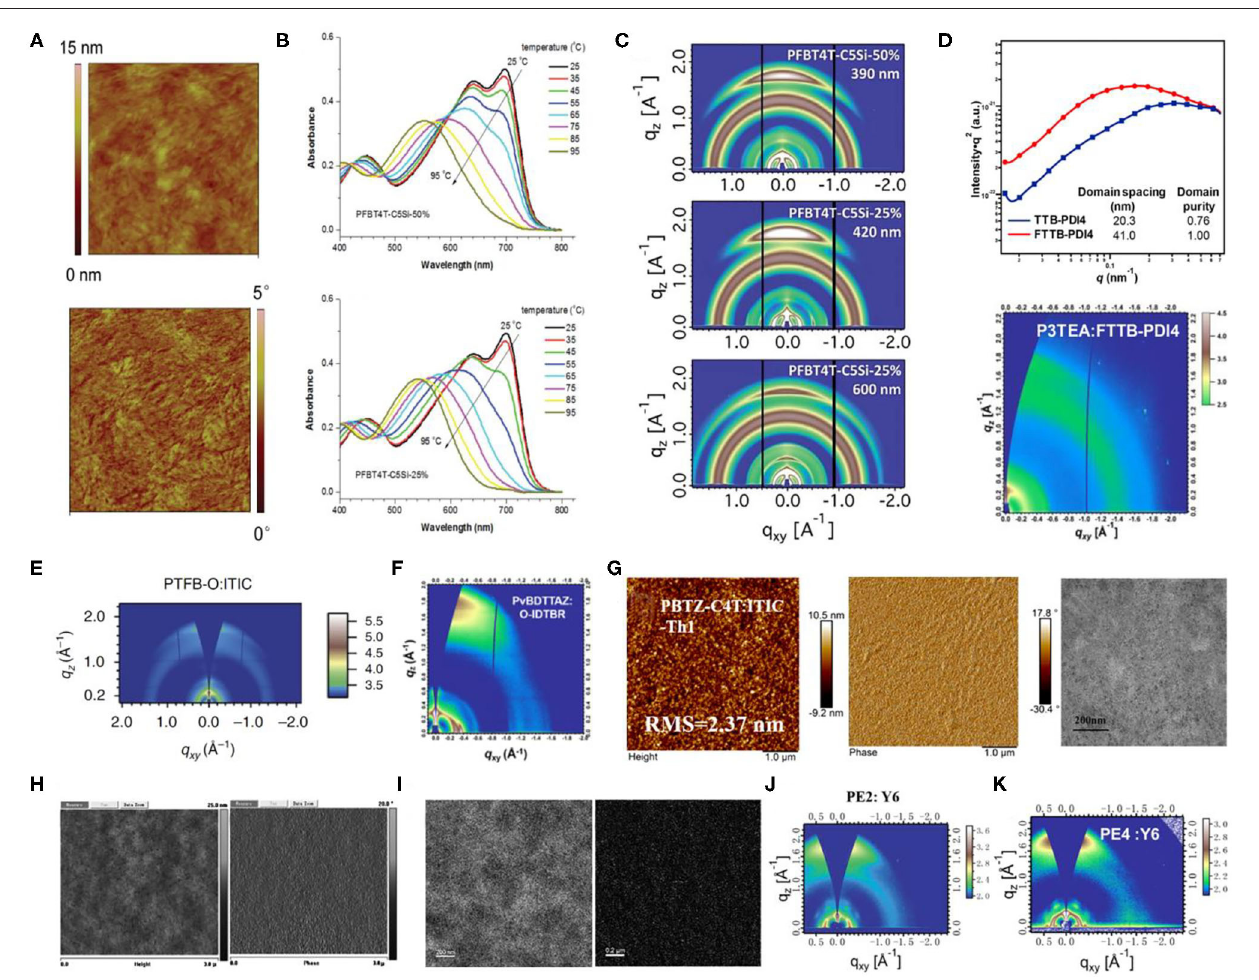
FIGURE 11 | (A) AFM images (1 × 1mm) of PffBT4T-2DT:SF-PDI2 blends. Copyright 2015, The Royal Society of Chemistry. (B) The evolutions of UV-vis absorption spectra of PFBT4T-C5Si-50% (top) and PFBT4TC5Si-25% (bottom) in chlorobenzene (1 × 10 − 5 M) during the heating process from 25 to 95 ◦ C. Copyright 2017, The Royal Society of Chemistry. (C) Grazing incidence X-ray diffraction (GIXD) 2D scattering images of thick BHJ films of PFBT4T-C5Si-50% and PFBT4T-C5Si-25%. Copyright 2017, The Royal Society of Chemistry. (D) RSoXS profiles (top) of P3TEA:TTB-PDI4 and P3TEA:FTTBPDI4 and 2D GIWAXS pattern (bottom) of P3TEA:TTB-PDI4. Copyright 2017, American Chemical Society. (E) Two-dimensional GIWAXS pattern of PTFB-O:ITIC blend film. Copyright 2016, Reproduced with permission. (F) 2D GIWAXS patterns for PvBDTTAZ:IDTBR films. Copyright 2017, American Chemical Society. (G) AFM and TEM images of PBTZ-C4T:ITIC-Th1 blend film. Copyright 2019, American Chemical Society. (H) AFM topography images (left) and phase-contrast images (right) of PBDTT–DTTBT/PC70BM (1:1.5) films. Copyright 2012, The Royal Society of Chemistry. (I) Zero-loss high-resolution phase-contrast TEM images (left) of PBDTT–ttTPD:PC71BM blends (1:1 wt/wt) cast from chloroform with 3 vol% DIO and nitrogen mapping ESI images (right) of PBDTT–ttTPD:PC71BM blends (1:1 wt/wt) cast from chloroform with 3 vol% DIO by a three-window method (N atom, 403.5eV). Copyright 2014, The Royal Society of Chemistry. (J) The 2D GIWAXS patterns of the PE2:Y6 blend films. Copyright